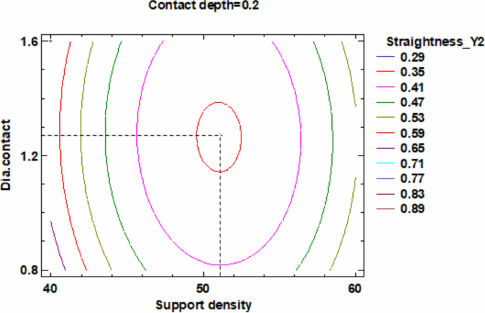
Figure 27. Contours of Estimated Response Surface for Straightness_Y2 and centre contact depth.